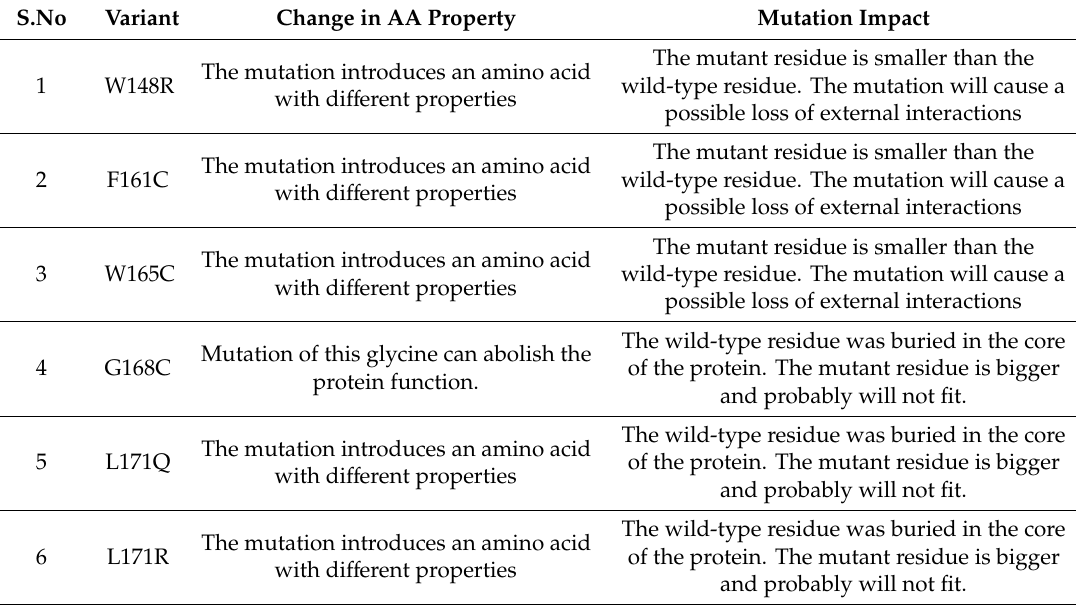
Table 2. Phenotypic e ff ect prediction of FLNB variant (missense) using the SNPe ff ect server. S.No Variant Tango Waltz Limbo FoldX 1 W148R T.1 W.2 L.1 Reduces the protein stability. 2 F161C T.1 W.1. L.1 Reduces the protein stability. 3 W165C T.1 W.1. L.1 Severely reduces the protein stability. 4 G168C T.1 W.1. L.1 Severely reduces the protein stability. 5 L171Q T.1 W.1. L.1 Reduces the protein stability. L171R T.1 W.1. L.1 Severely reduces the protein stability.